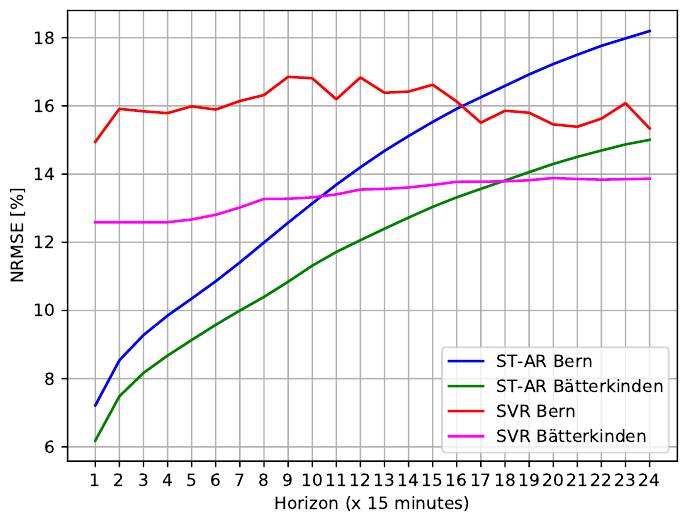
Figure 10. Forecast error (NRMSE) comparison between ST-AR and SVR with numerical weather predictions (NWP) for a single site. The forecast horizon is six hours in steps of 15